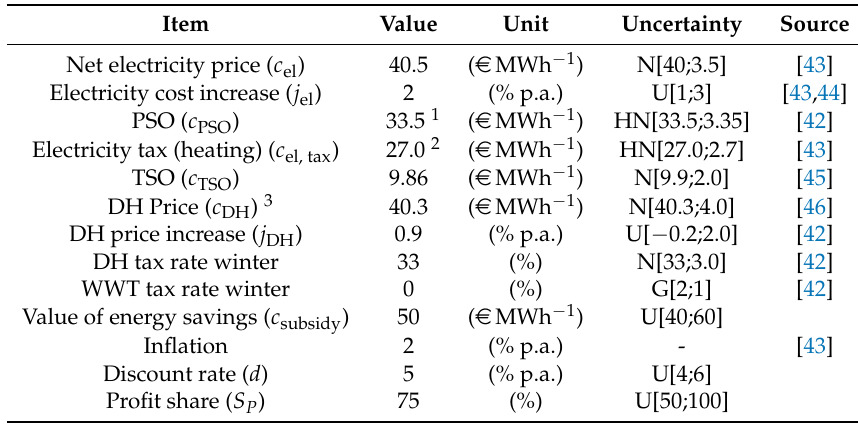
Table 2. Summary of the economic model parameters and their distribution in the input uncertainty space for the evaluation of the case studies (uniform U[lower;upper]; normal N[ µ ; σ ]; half-normal HN[ µ ; σ ]; gamma